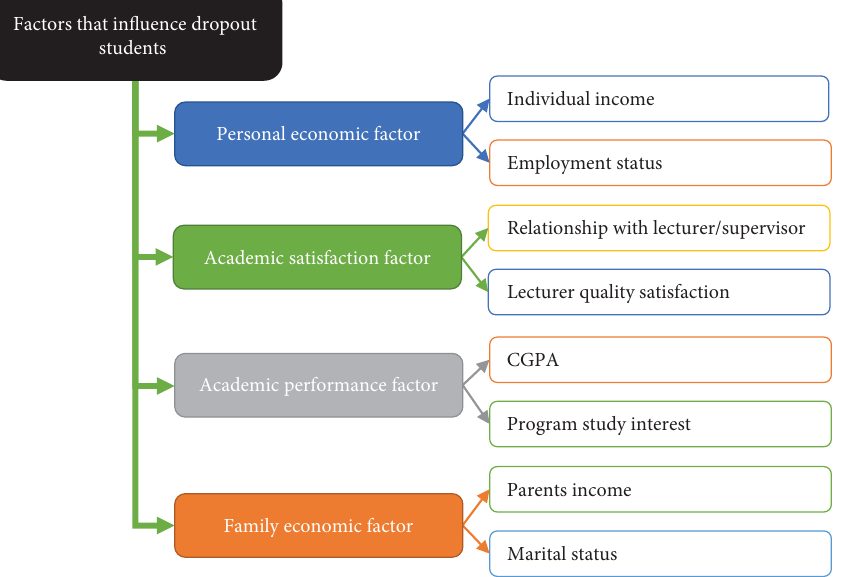
F IGURE 7: Factors that in fl uence dropout